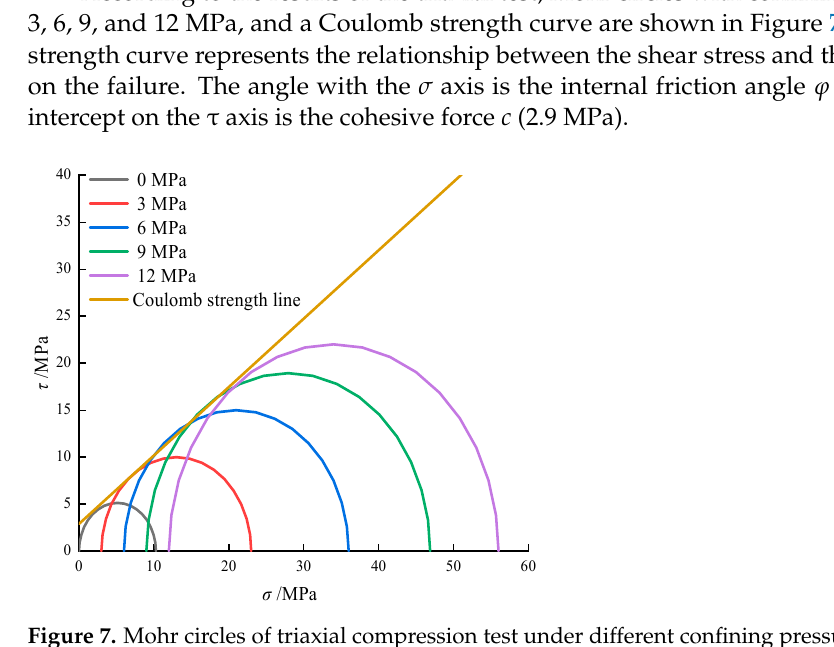
with a good regression coefficient of R 2 =